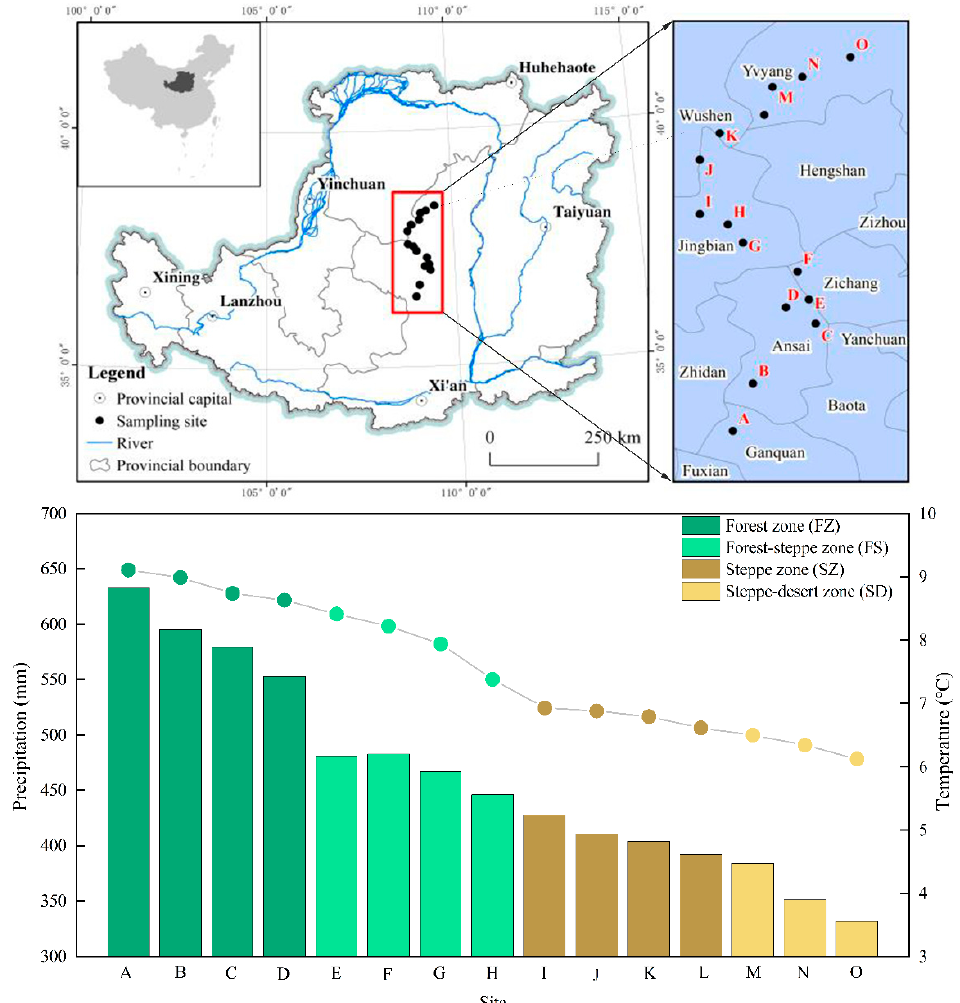
Figure 1. Location of the study area and illustration of sampling sites of mean monthly temperature and precipitation (1990–2010) along a 500-km-long latitudinal gradient on the Loess Plateau. All climate data (MAT and MAP) was obtained from China Meteorological Data Sharing Service System (http://data.cma.cn/, Accessed on 10 May 2021).